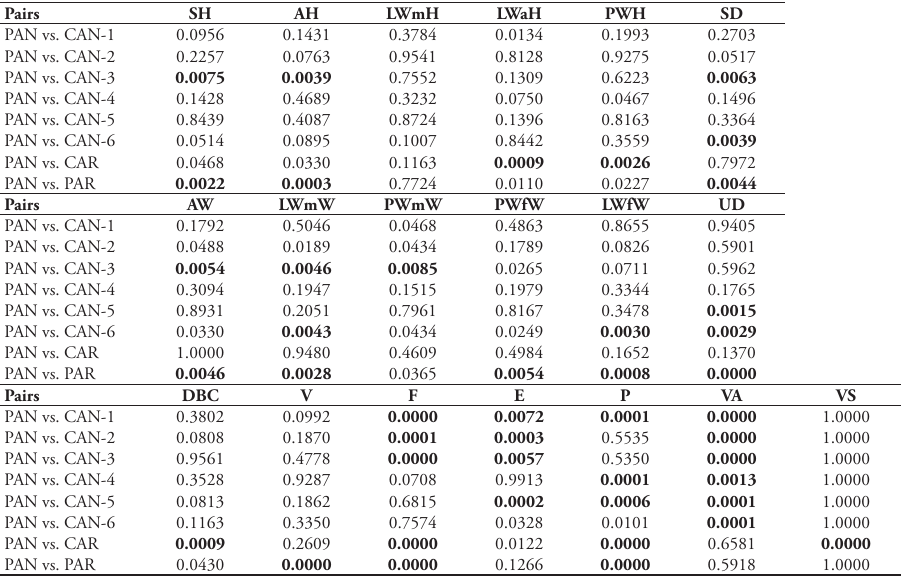
Table 6. Results of Dunn’s test with Benjamini-Hochberg correction ( α = 0.01) for shell and genital characters (in bold P ≤